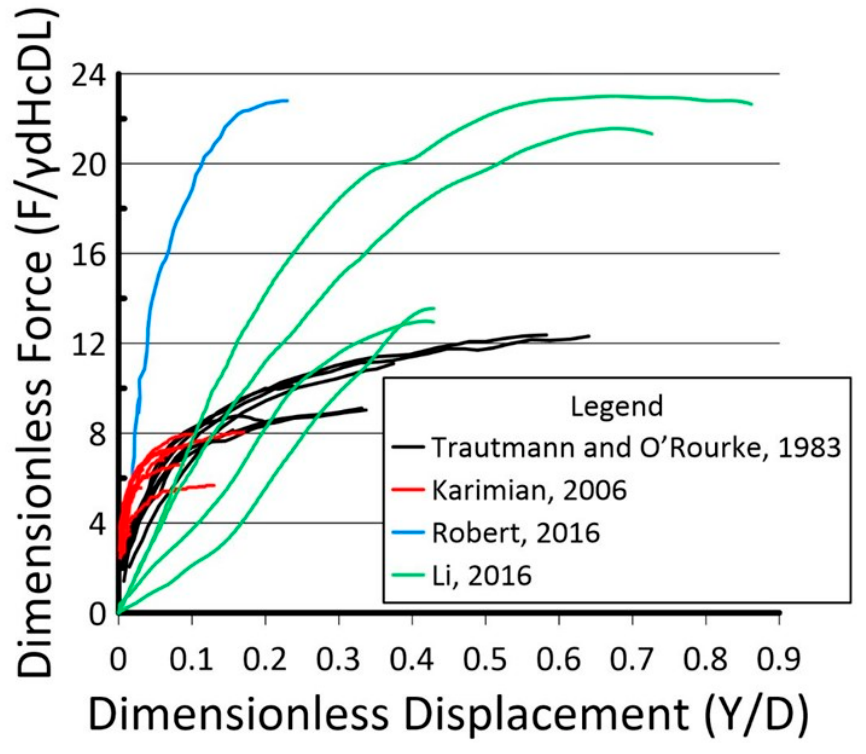
Figure 2. Dimensionlessforcevs. displacementtestdataformediumsand(16 kN/m 3 < γ d ≤ 16.7 kN/m 3 ). Experiments performed by